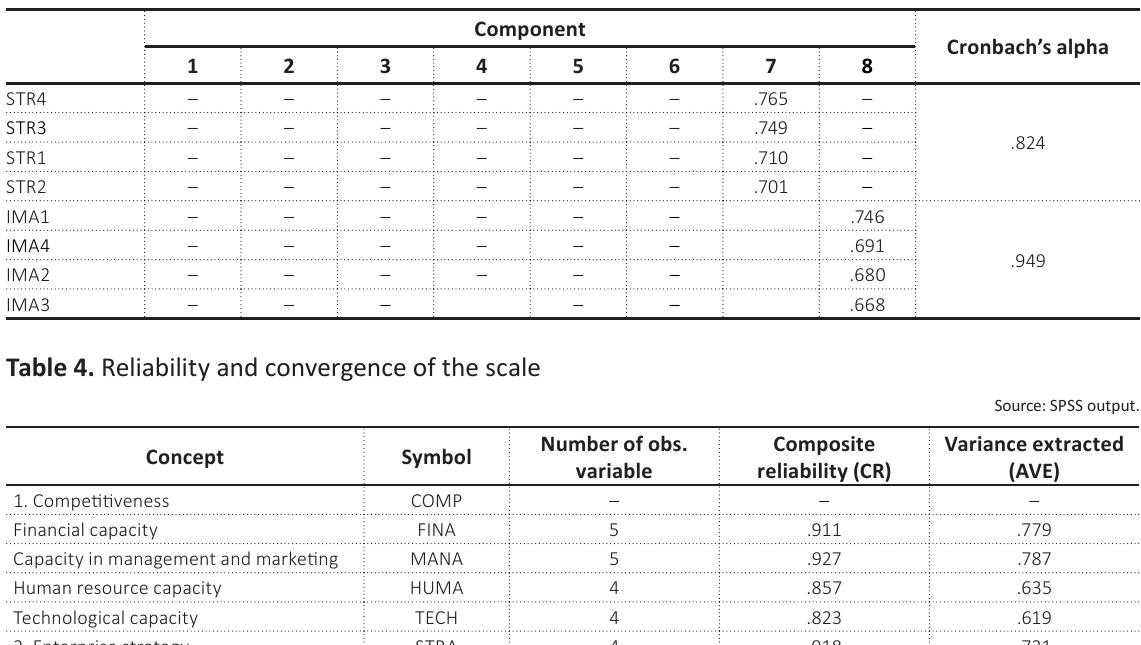
Table 3 (cont.). Rotated component matrix and Cronbach’s alpha testing